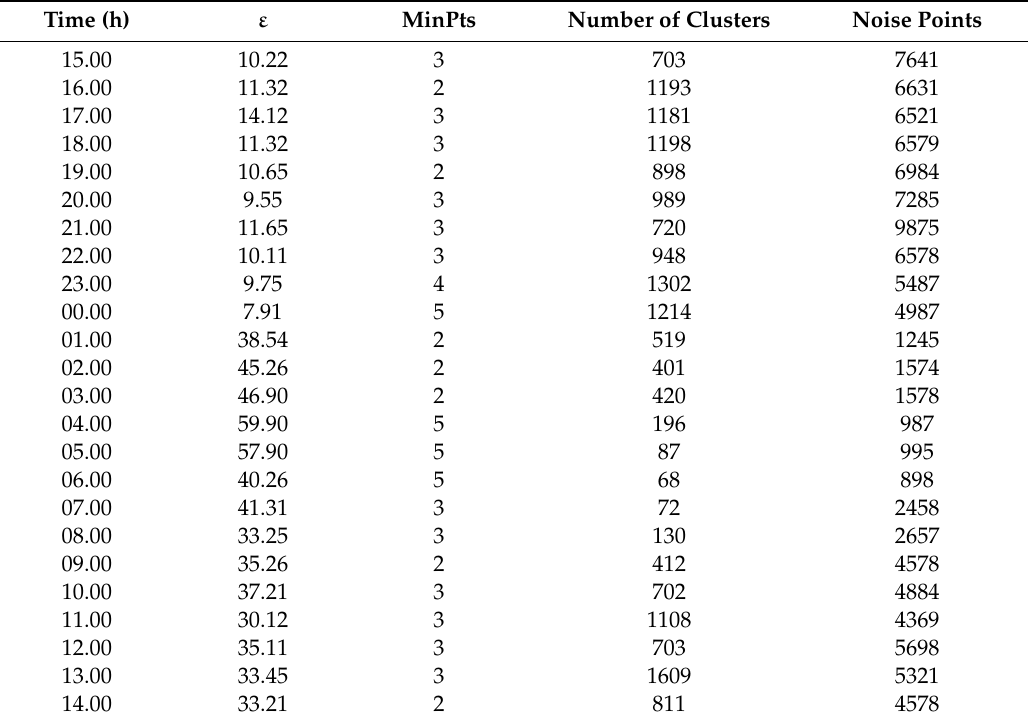
Table 3. SOM and DBSCAN, first stage clustering results in the New Year’s Eve day in NYC.